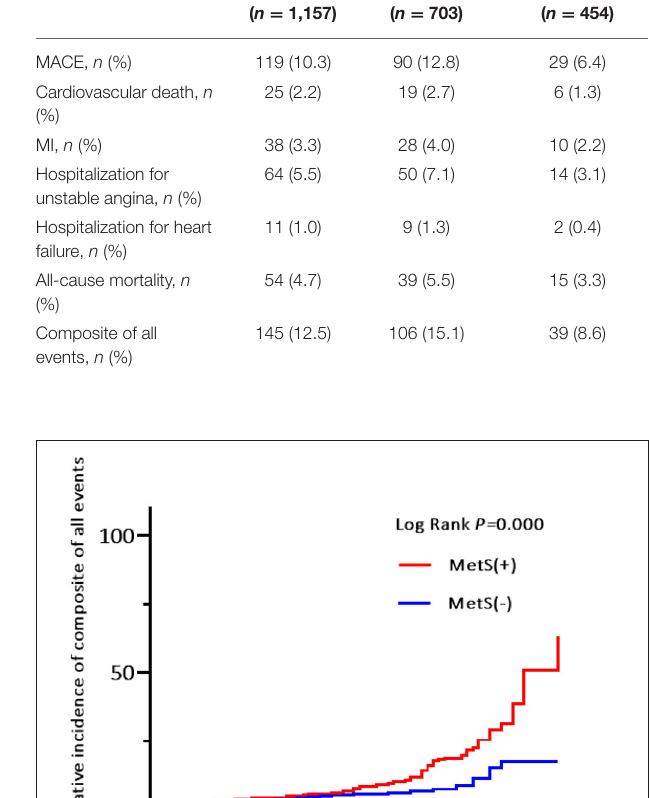
TABLE 2 | Association between MetS and incidence of all events. Unadjusted analysis